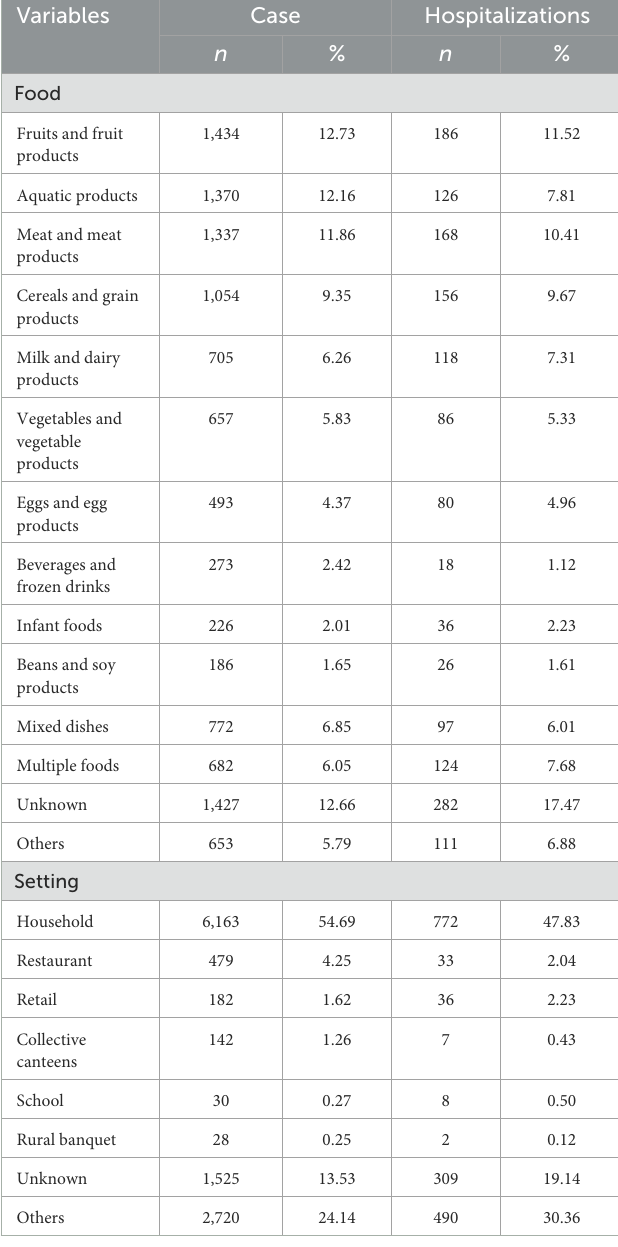
TABLE 2 Food and Setting distribution of Salmonella positive cases in Zhejiang Province from 2012 to 2021.